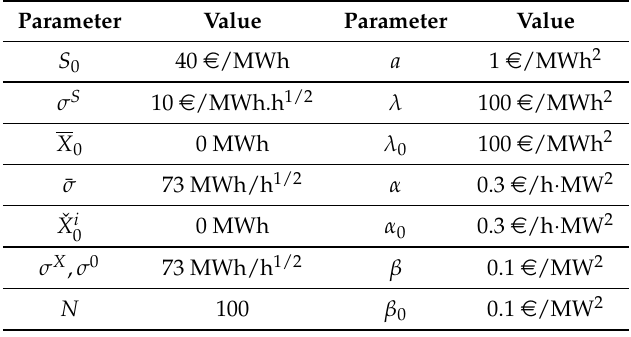
Table 1 specifies the model parameters. Table 1. Parameters of the model.